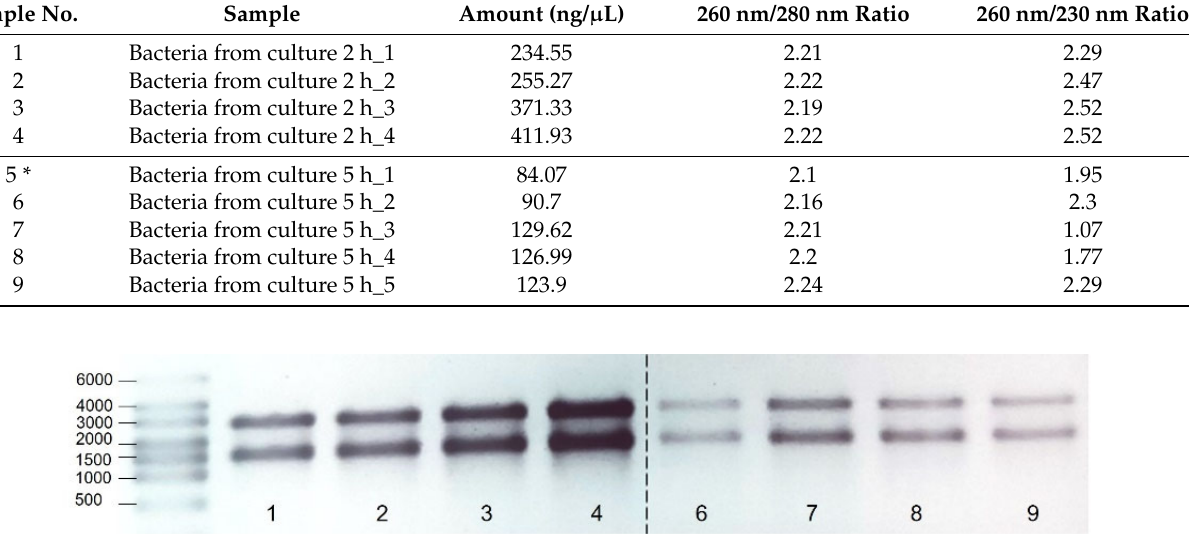
Figure 1. Exemplary image of gel electrophoresis of RNA isolated from endothelial cells (host), S. aureus from culture and intracellular S. aureus . The host lane shows 28 S and 18 S rRNA, while bac- terial lanes show 23 S and 16 S rRNA. No host rRNA is detectable in the lane of intracellular S. aureus . There were no eukaryotic rRNA bands detected in the lane showing RNA from intracellular S. aureus , indicating a low contamination with host RNA. Agarose gels of all individual bacterial samples are shown in Figures 2 and 3. Individual eukaryotic RNA samples are shown in Supplementary Figure S1 and Table S1. These findings demonstrated the integrity of isolated eukaryotic and bacterial RNA. In addition, the quality was assessed by a Nanodrop measurement, which is frequently used to determine RNA quality (Tables 1 and 2). Table 1. List of RNA samples of S. aureus (shown in Figure 2) in culture after 2 h and 5 h of incubation (condition I) including the amount recovered and the ratios measured via Nanodrop. * Not enough material for gel electrophoresis available .